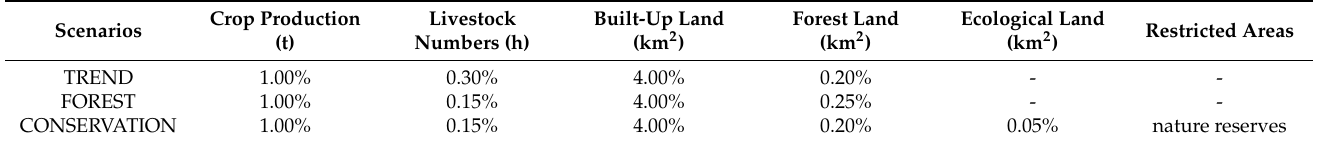
Table 1. Growth rates of demands for land use under different scenarios